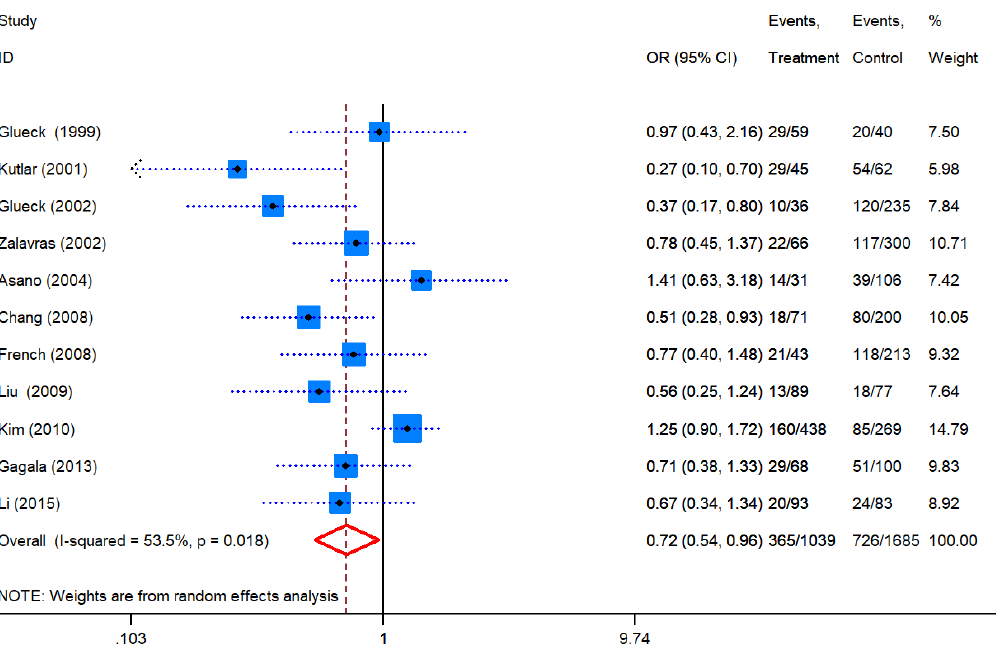
Figure 2: The forest plot of OR for MTHFR C677T polymorphism and non-traumatic osteonecrosis of the femoral head(CC vs CT+TT).